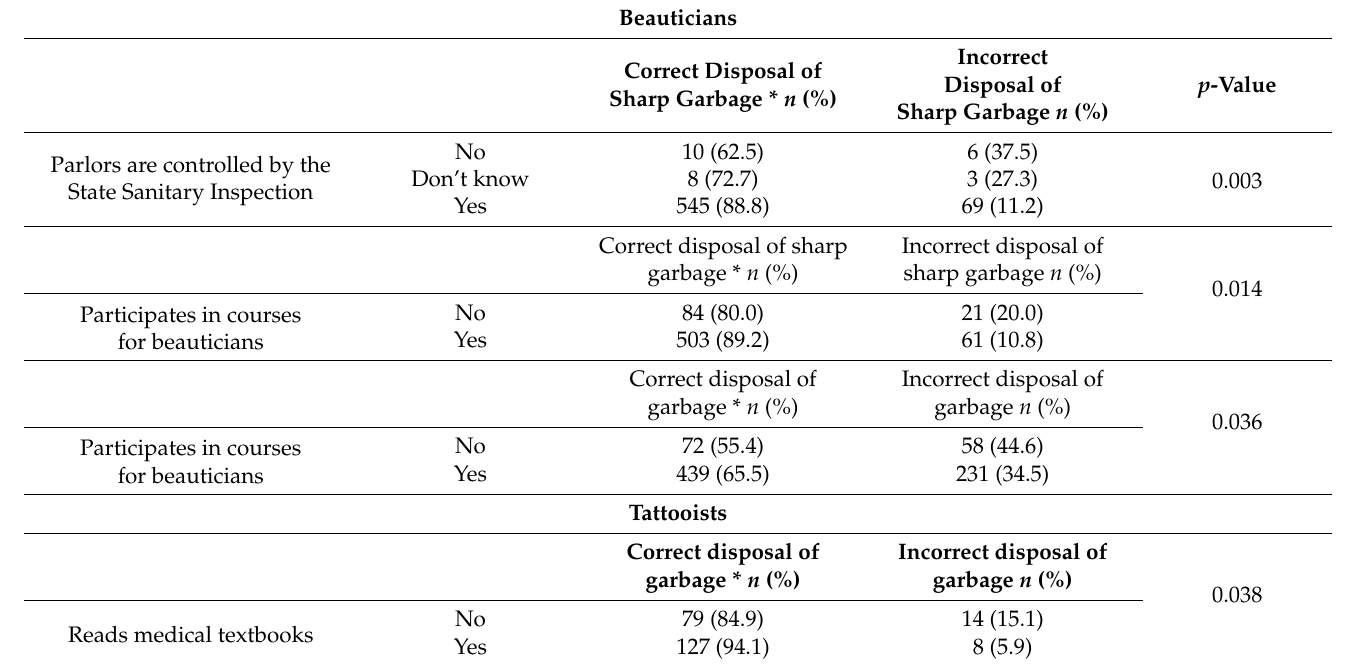
Table 3. Disposal of waste and sources of knowledge of beauticians and tattooists. Beauticians Correct Disposal of Sharp Garbage * n